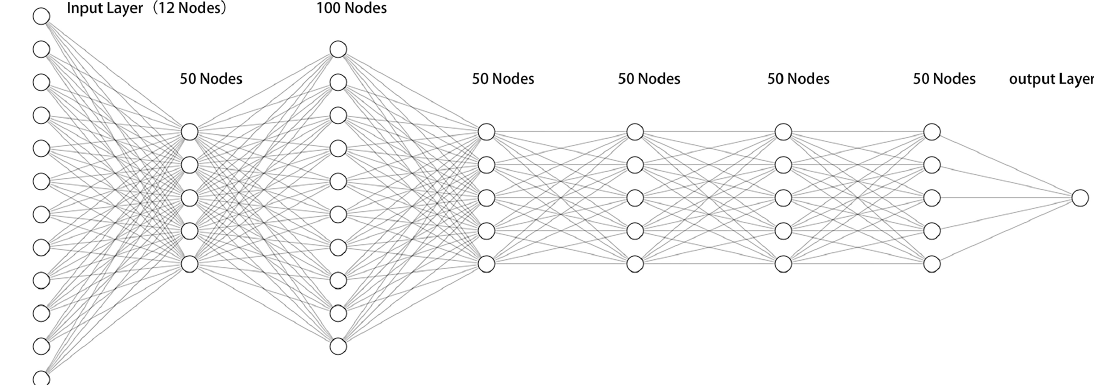
Figure 1. The structure of the DNN (deep neural network). The neural network is composed of an input layer, hidden layers, output layers and the connections between each layer. The function of each hidden layer is to transform the features of the network